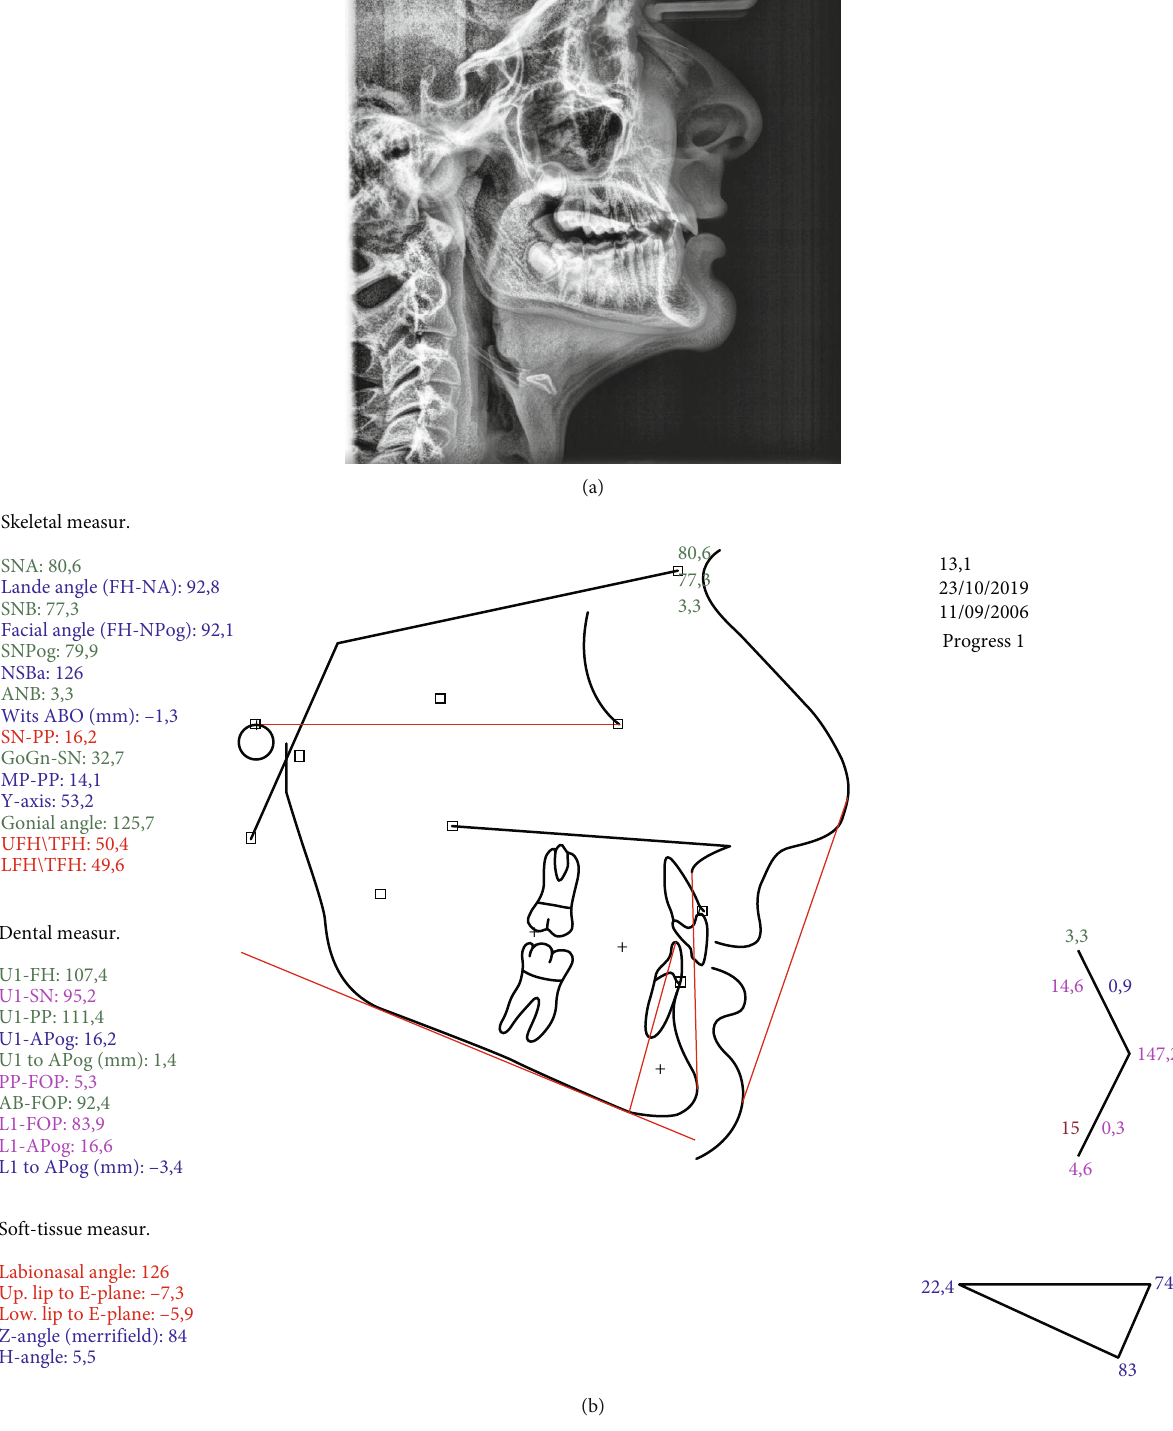
Figure 6: (a) Lateral cephalogram and (b) tracing after MA